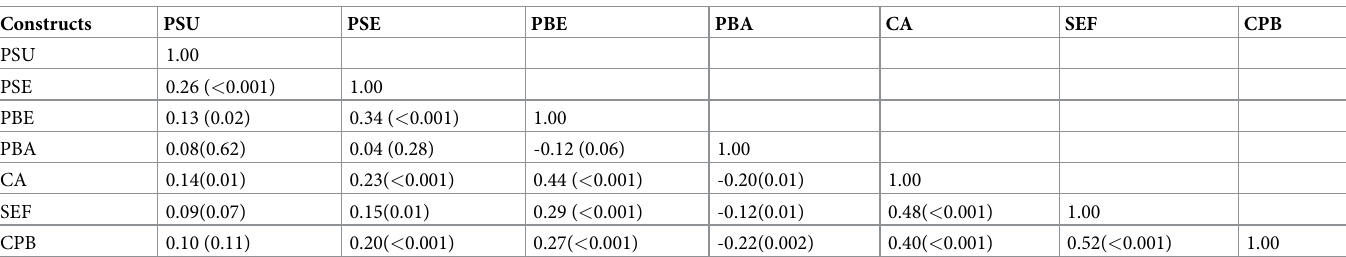
Table 4. Spearman correlation among Health Belief Model